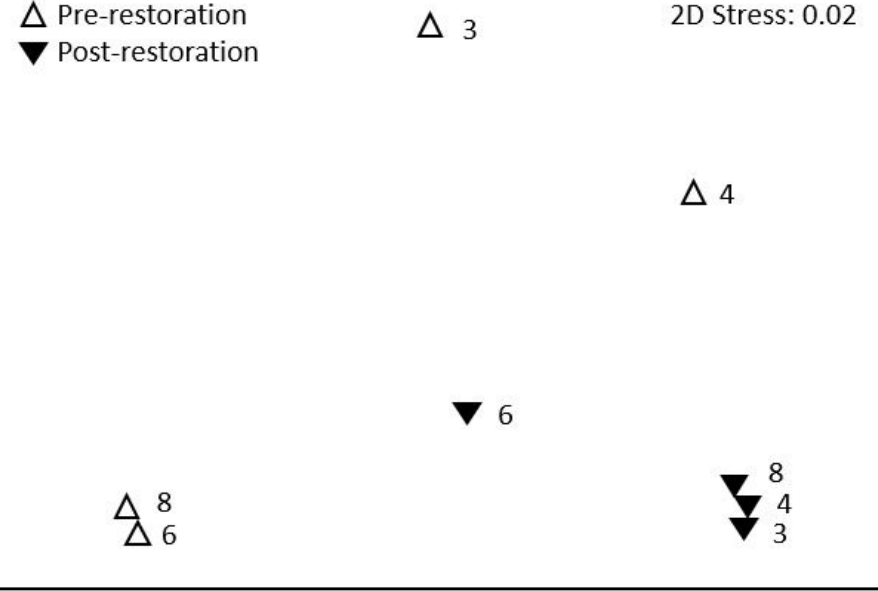
Figure 2. Non-metric multidimensional scaling plot showing fish community convergence between 1998 and 2007.